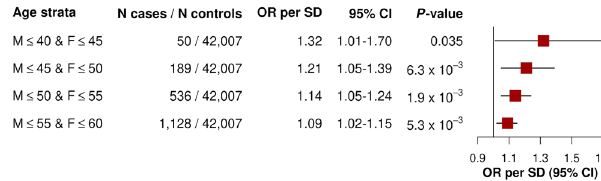
Fig. 9 Predictive effects of RVGRS950 LDLR − among 4 age strata in UK Biobank participants. Odds ratios of RVGRS950 LDLR − are shown for UK Biobank European participants across 4 age strata. Ages correspond to earliest event across all pertinent ICD-10 codes that encompassed our CAD de fi nition. Squares represent odds ratios that are expressed in terms of a 1 SD change in RVGRS. All odds ratios were calculated using a multivariable logistic regression model that was adjusted for sex and the fi rst 20 principal components of ancestry. Horizontal lines indicate the 95% con fi dence interval of the odds ratio. OR indicates odds ratio, SD indicates standard deviation, CI indicates con fi dence interval, M indicates male, and F indicates female, and RVGRS950 LDLR − refers to rare variant genetic risk score from the top 950 discovery genes, excluding LDLR . LDLR refers to low-density lipoprotein receptor. Source data are provided as a